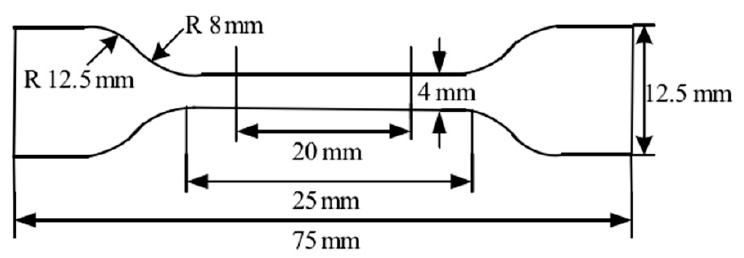
Figure 1. The detailed dimensions of tensile tests of the